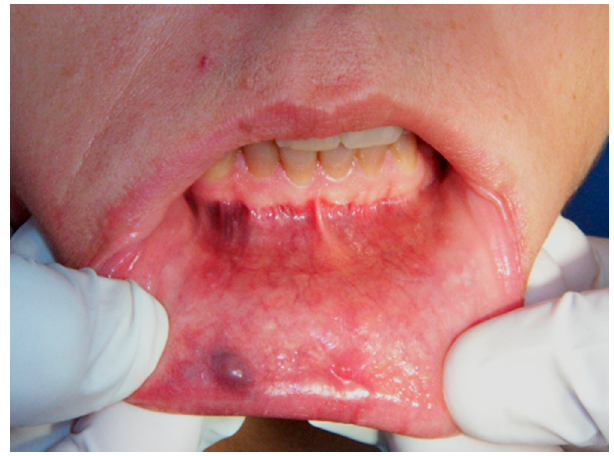
Figure 1. Clinical aspect of venous malformation (VM) on the lower lip.